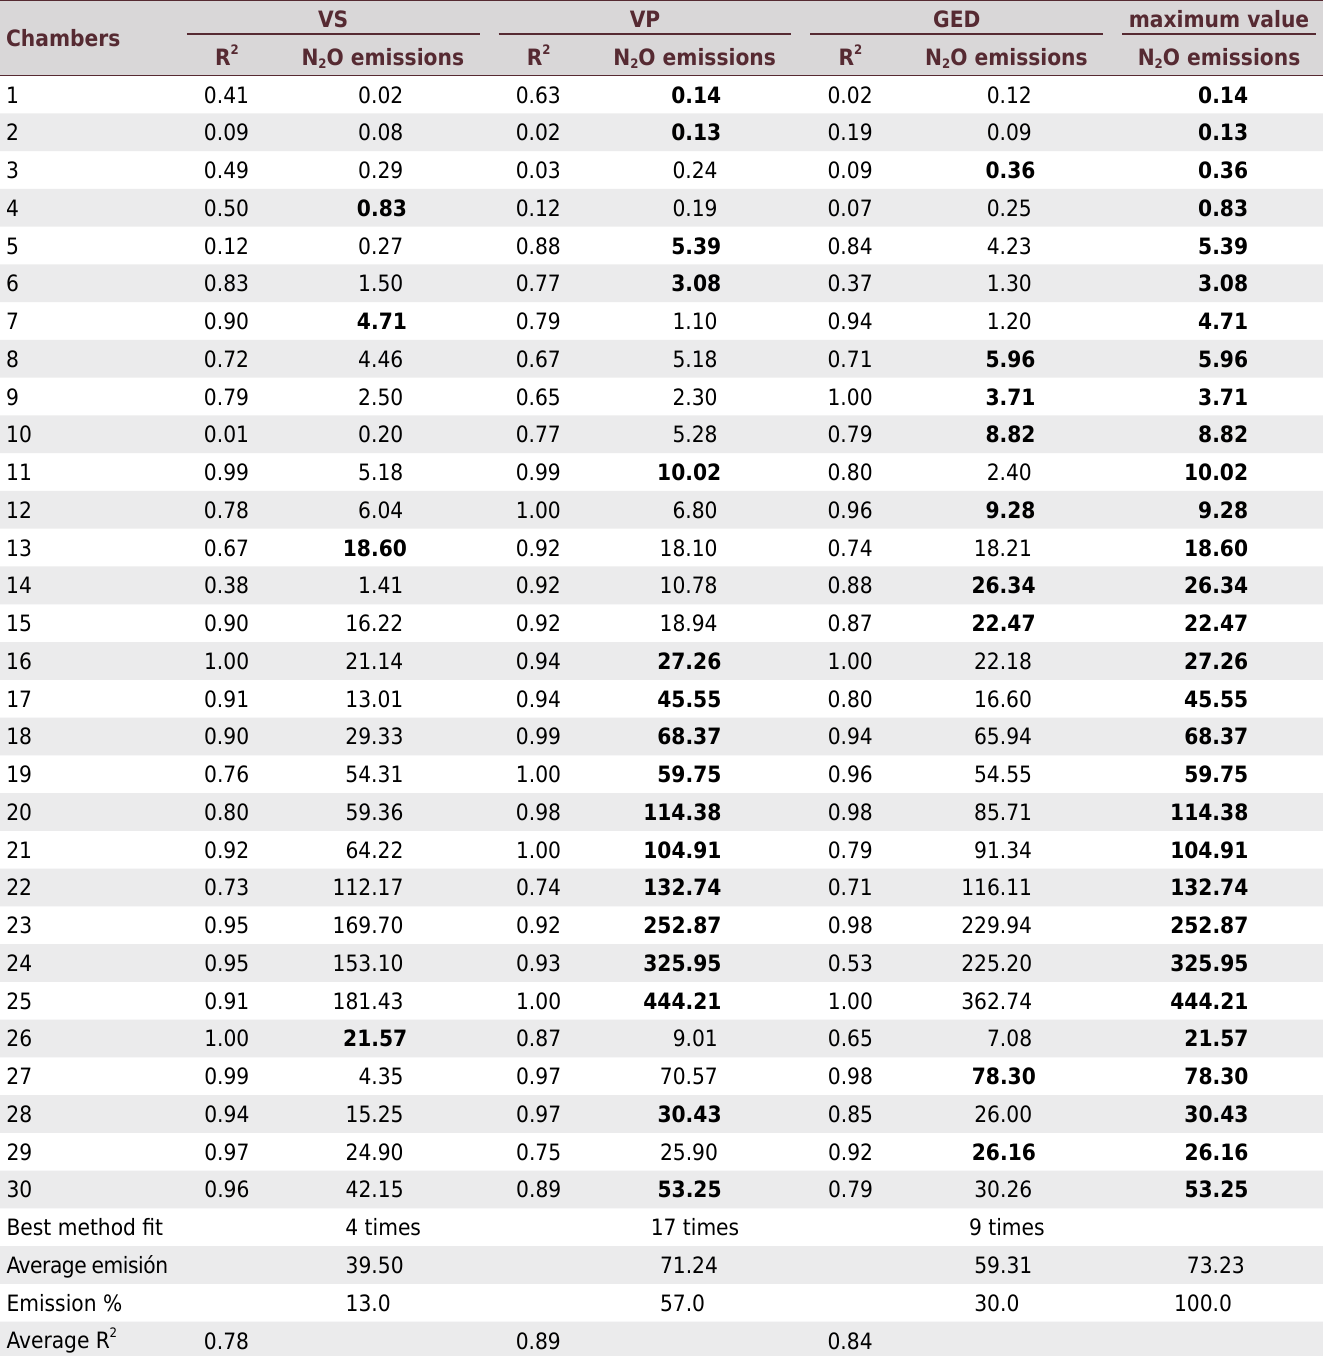
Table 1. N-N 2 O emission values and linear regression adjustments (R 2 ) for the Vacuum by Manual Pump (VP), Vacuum by syringe (VS), and Gas Exchange by Displacement (GED) methods for each of the 30 studied chambers. The maximum emission values are shown in bold